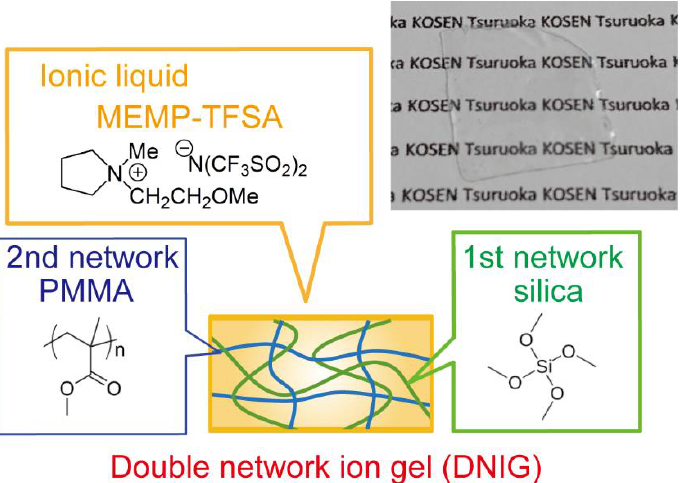
Figure 1. Schematic illustration of DNIG obtained by one-pot synthesis. A photograph of DNIG thin film (thickness: 200 µm) was also inserted in the upper right.